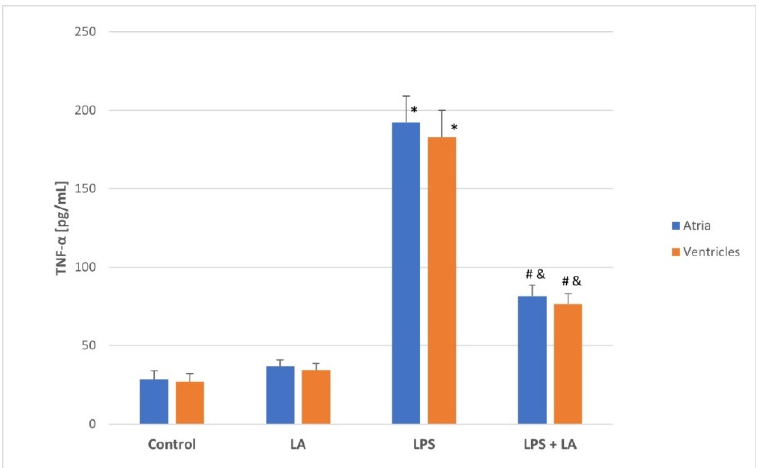
Figure 1. Effect of LA, LPS, and LPS + LA on TNF- α levels in ventricular and atrial homogenates. Results are shown as mean ± S.E.M. n = 8. * p < 0.05 vs. control, LA; # p < 0.01 vs. LPS; & p < 0.05 vs. control, LA. LA—alpha lipoic acid, LPS—lipopolysaccharide.